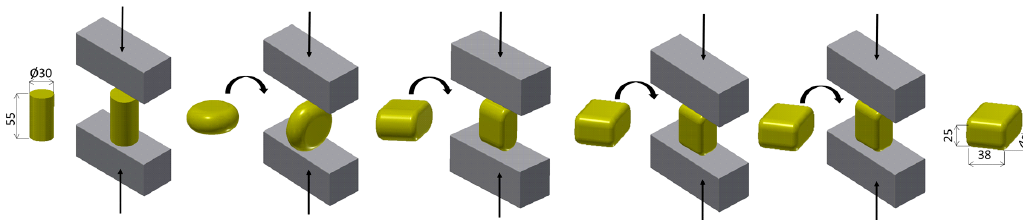
Figure 4. ( a ) Semi-solid processing routes, regimes 1–6; ( b ) quenching and tempering route, regime 7.